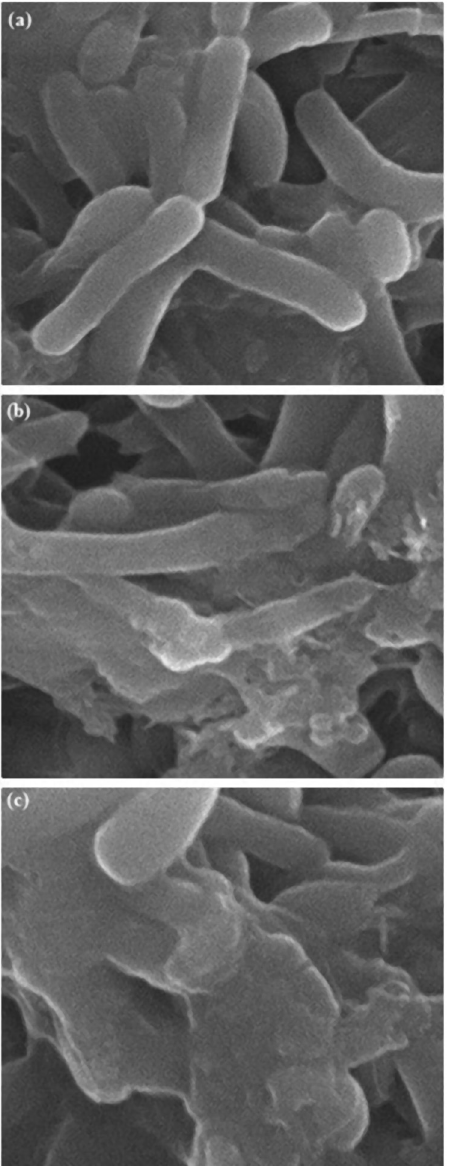
Figure 7: SEM micrographs of treated Salmonella typhimurium with phycosynthesized ( Sp SeNPs - A ) after 6 h ( b ) and 12 h ( c ) , compared with control ( a )